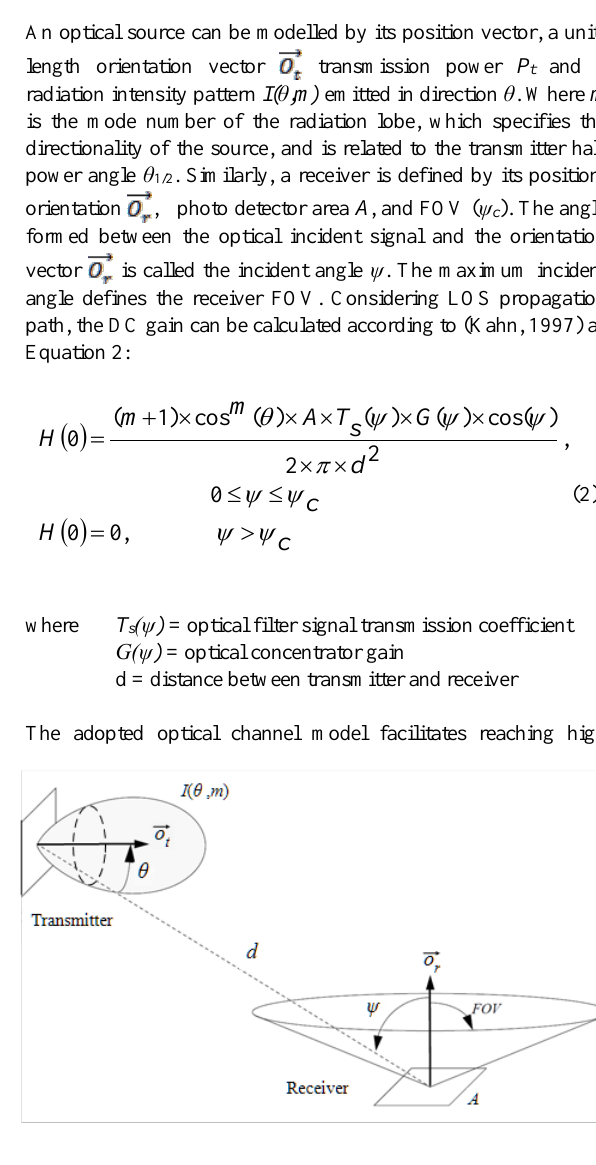
Figure 1. Directed LOS link